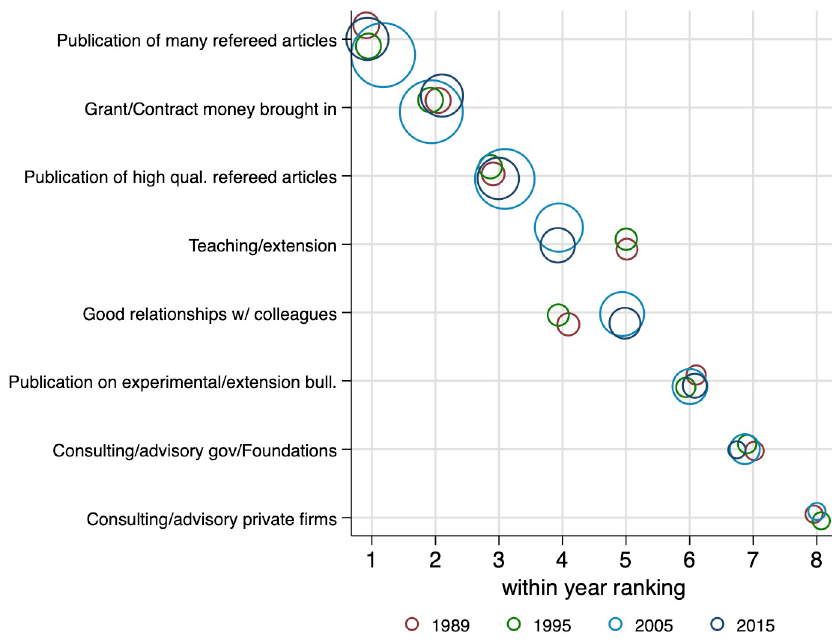
Fig 4. Faculty perceptions of T&P criteria. This figure displays the criteria ranking by year. The circles are weighted by the within-year average per item, with larger circles reflecting larger within-year averages. N = 3,045.